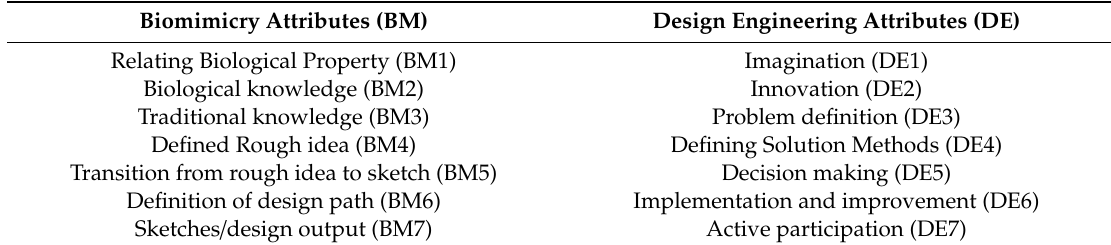
Table 1. Biomimicry and Design Engineering Attributes for Statistical Analysis.